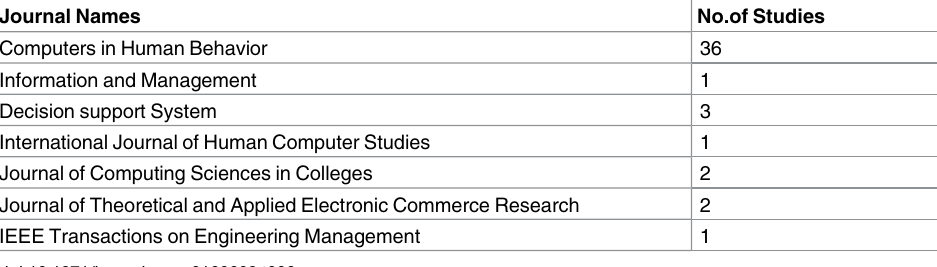
Table 6. Journal Names and no. of Collated Studies.